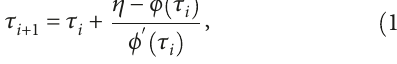
algorithm adopts SPGL1 algorithm to solve the group